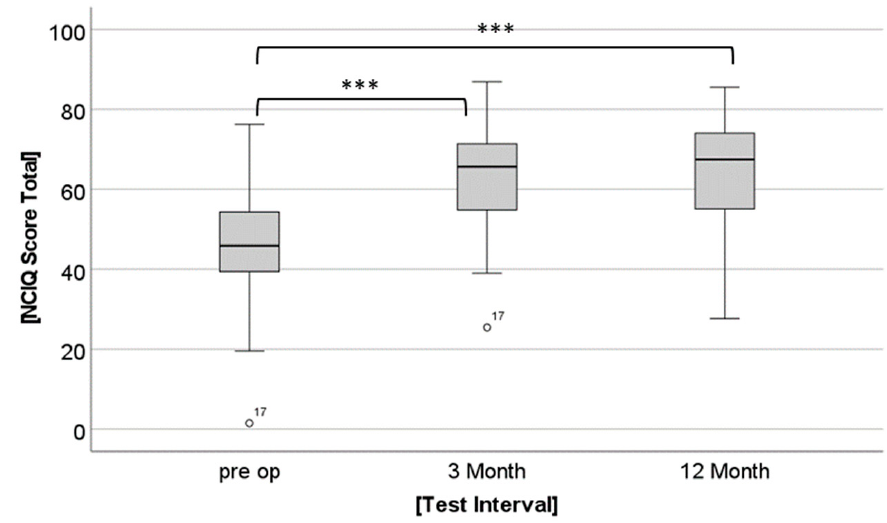
Figure 3. Mean scores of the Nijmegen Cochlear Implant Questionnaire (NCIQ) for the combined groups at the three test intervals (preoperative and 3 and 12 months postoperative). Small circles with number indicate outliers. ◦ means outliers, *** means significant differences p ≤ 0.001.